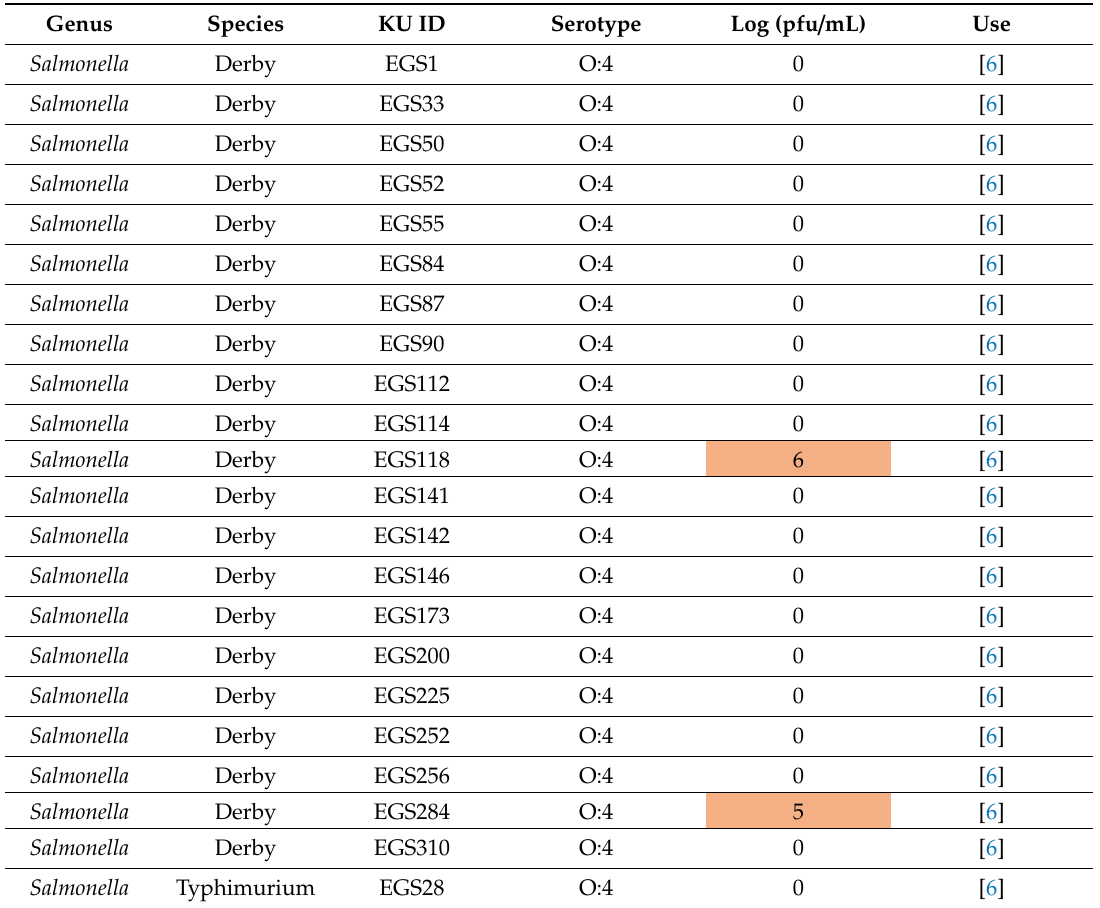
Table A2. Complete host range. A stock of S144 propagated on S . Infantis S15 (1*10 9 pfu / mL) has been spotted on lawns of 211 di ff erent Enterobacteriaceae and other Gram-negative bacterial strains. Genus, species, internal code for identification at the University of Copenhagen (KU ID), serotype (ND, not determined), log of the titer on strain (plaque forming units / mL in orange the positive infections) and its use in this manuscript or in [6] have been